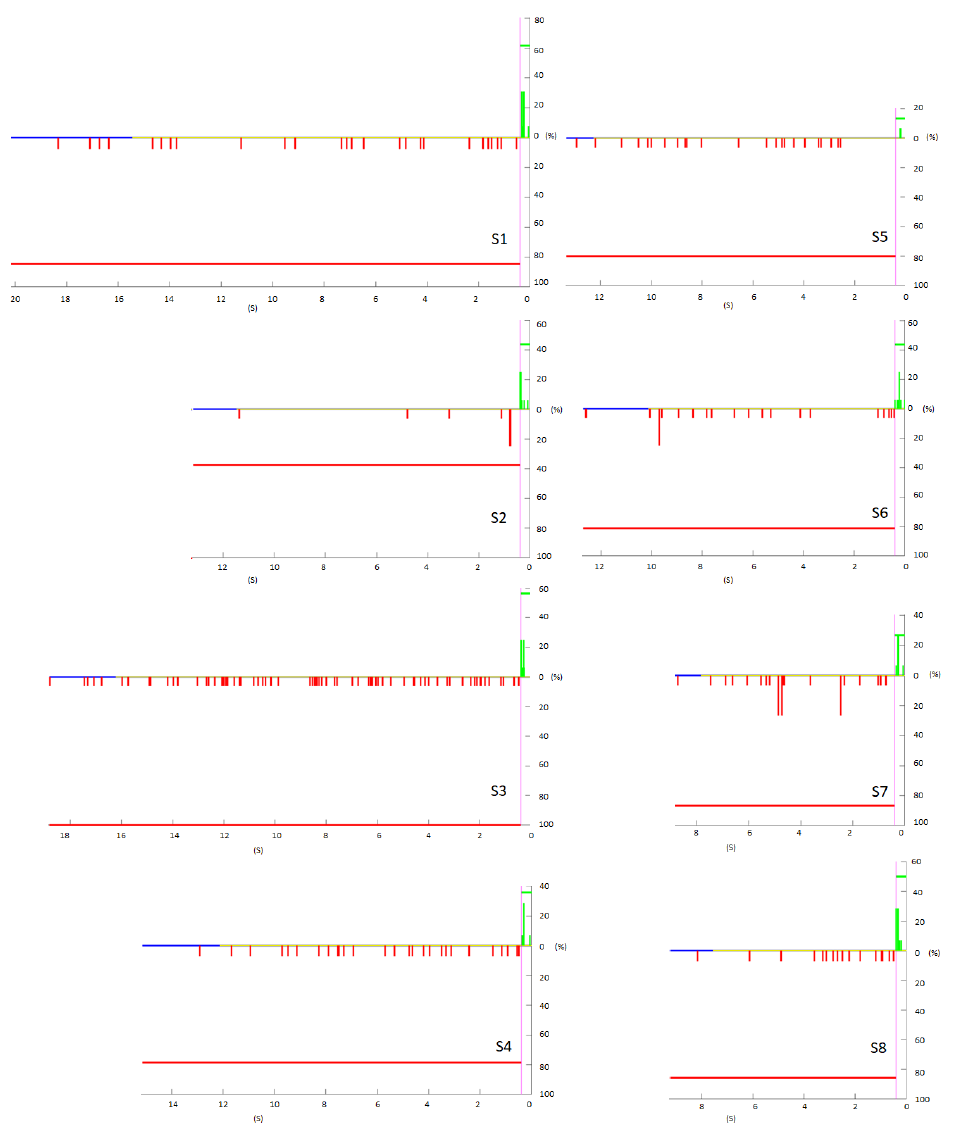
Figure 3. Pseudo-online with 16 repetitions. Horizontal line at 0, in yellow the mean of the first moment in which the PFs are evaluated. In blue, the temporary maximum where it is evaluated in yellow the mean of the time repetitions duration. The FPs are shown in red as they happened temporarily with respect to the change in the X axis, the value of Y is based on the percentage of times that they appeared at that moment. The red horizontal line is the average number of trials in which an FP appeared. Analogously, the TPs are shown in green and the average PT